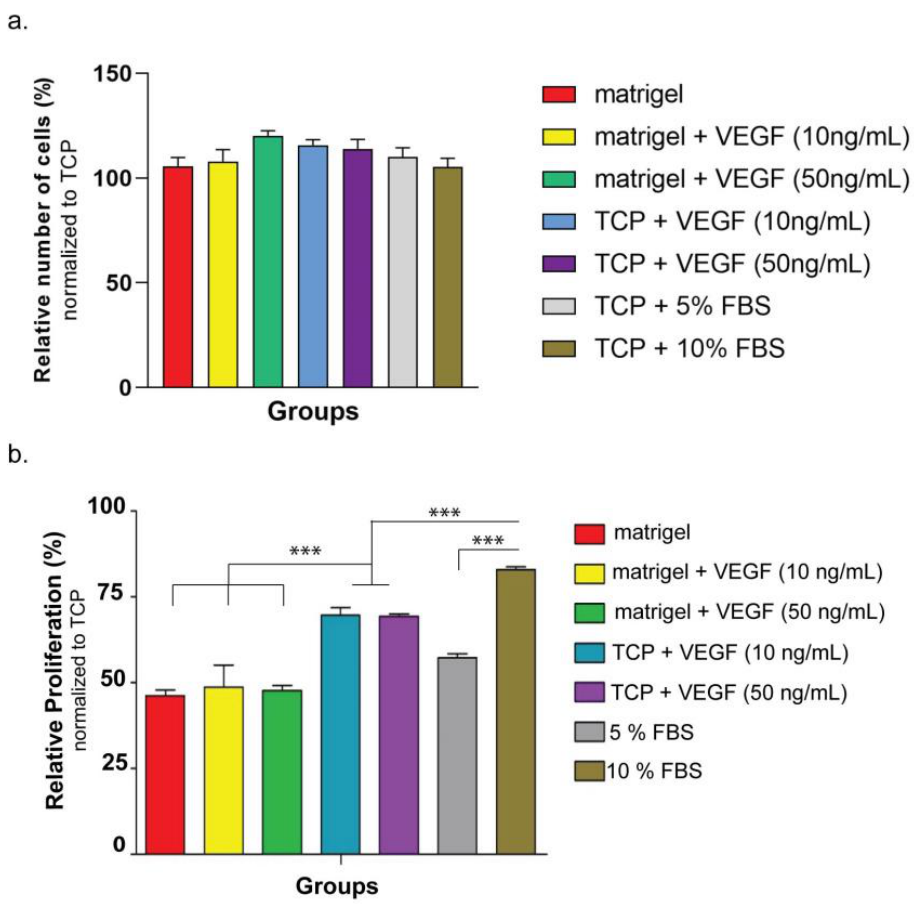
Figure 3. ( a ) Relative viability of HUVECs at 24 h cultured on Matrigel or bare tissue culture plate (TCP) with varying VEGF concentrations or FBS amount. The viability was normalized to HUVECs cultured on TCP with 15% FBS. ( b ) Relative number of HUVECs at 4 h cultured on Matrigel or TCP with varying VEGF concentrations or FBS amount. The average number of cells was normalized to HUVECs cultured on TCP with 15% FBS. Values represent mean ± SEM, n = 3 (*** p < 0.0001).